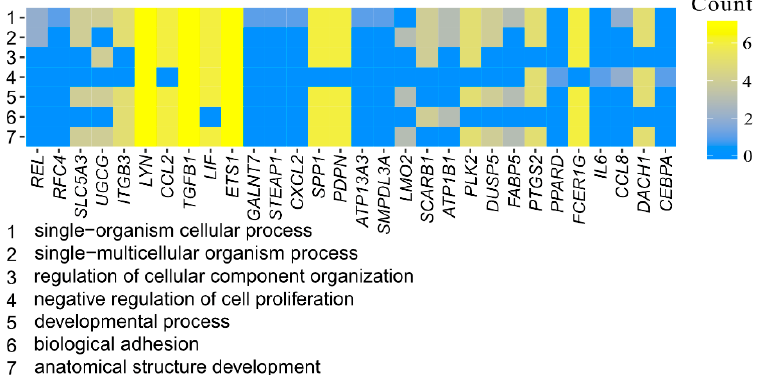
Figure 6. Heatmap showing the gene occurrence between differently expressed genes that belongs to anatomical structure development, biological adhesion, developmental process, negative regu- lation of cell proliferation, regulation of cellular component organization, single − multicellular organism process, and single − organism cellular process GO BP terms. The yellow color is associ- ated with gene occurrence in the GO Term. The intensity of the color is corresponding to amount of GO BP terms that each gene belongs to.